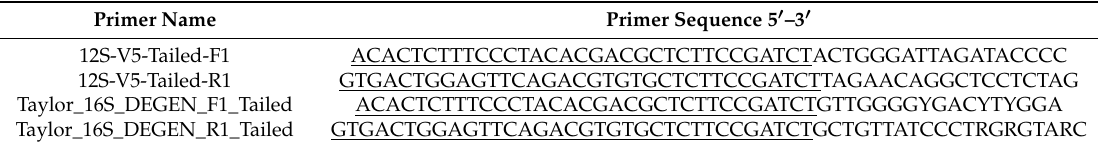
Table 3. Primers used for each assay, oriented 5 (cid:48) to 3 (cid:48) . For the first PCR round the assay specific (no underline) sequence was used as a primer. For the second PCR round, primers with the assay specific and tail sections (underlined) were